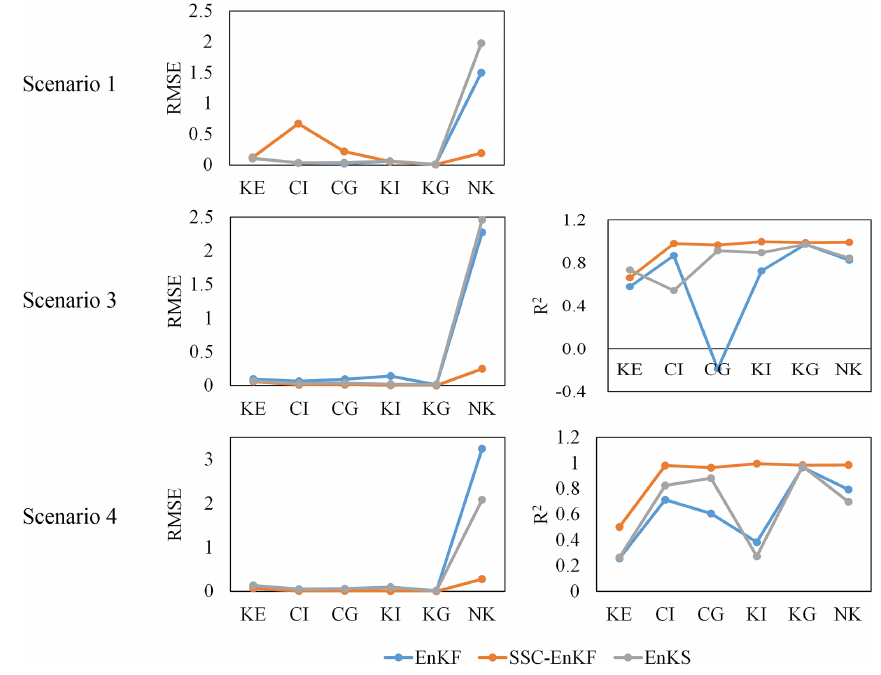
Figure 8. Comparison among EnKF, SSC-EnKF, and EnKS in the synthetic experiment with the Xinanjiang